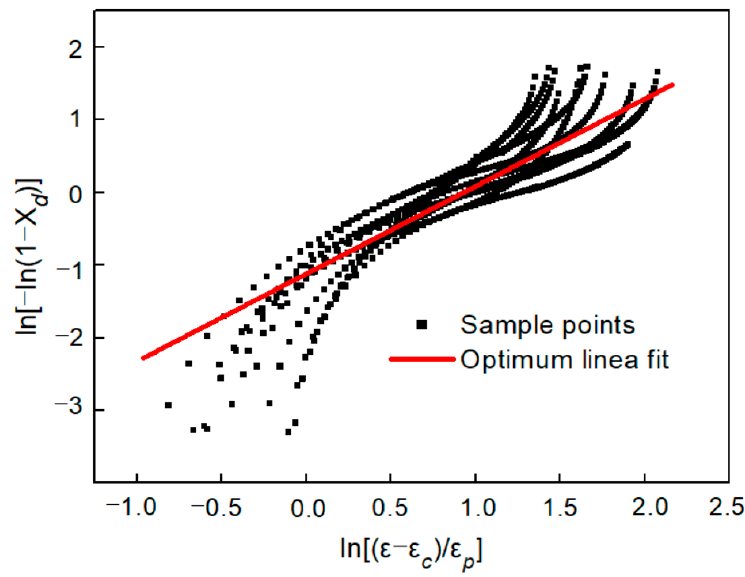
Figure 11. Relation between DRX volume fraction and strain.